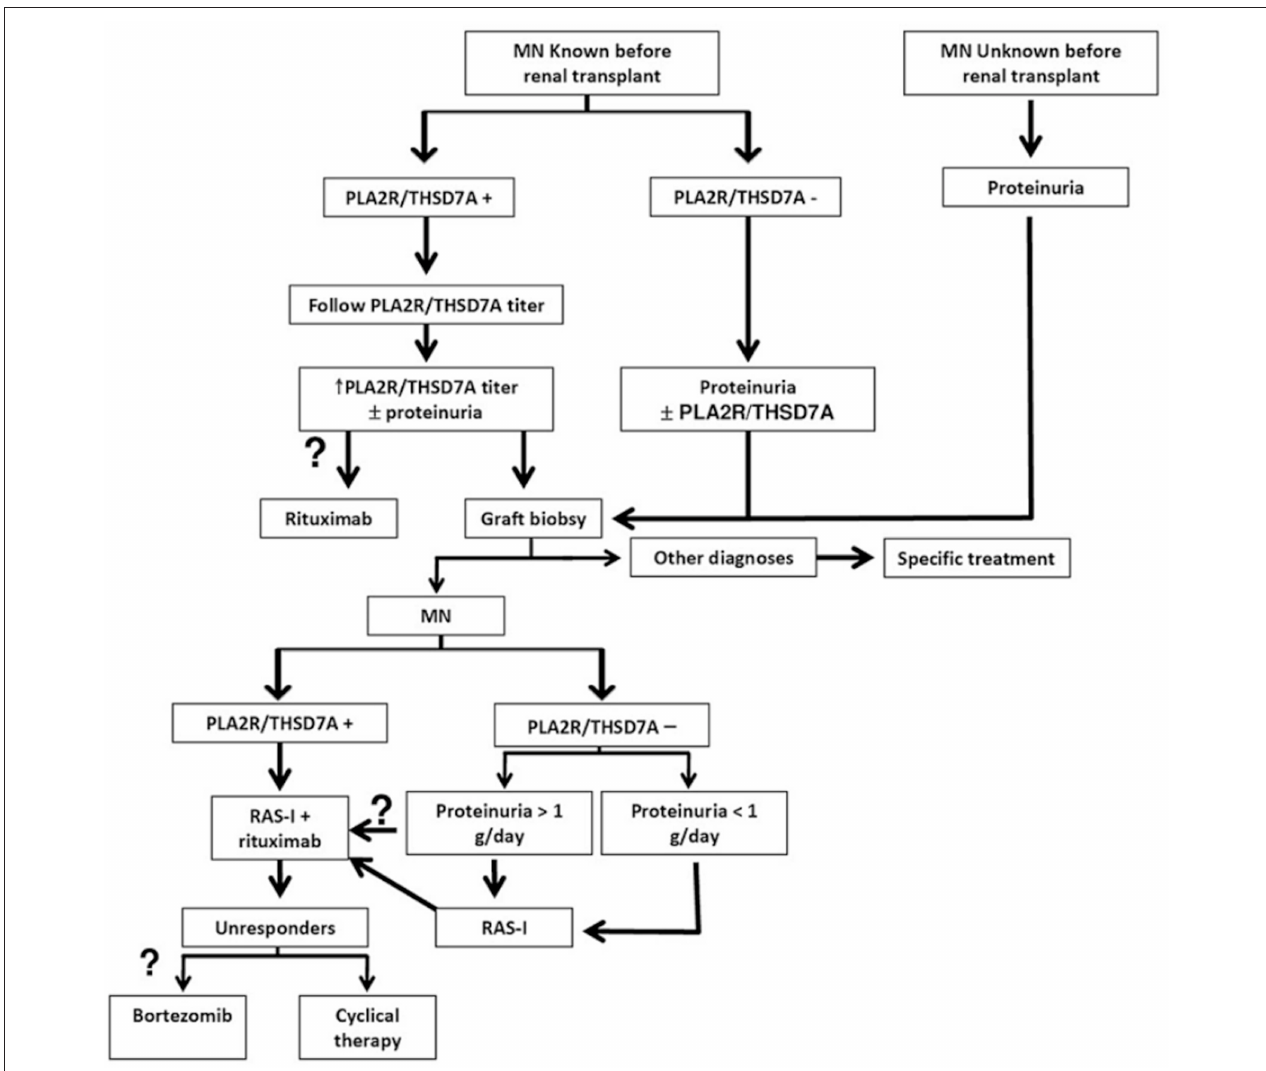
FIGURE 1 | Antibody-guided diagnosis and treatment algorithm for recurrent MN. RAS-I Renin- angiotensin system inhibitors, PLA2R anti-phospholipase A2 receptor, THSD7A anti- thrombospondin 1 type 1 domain containing 7A. Question marks on optional points.